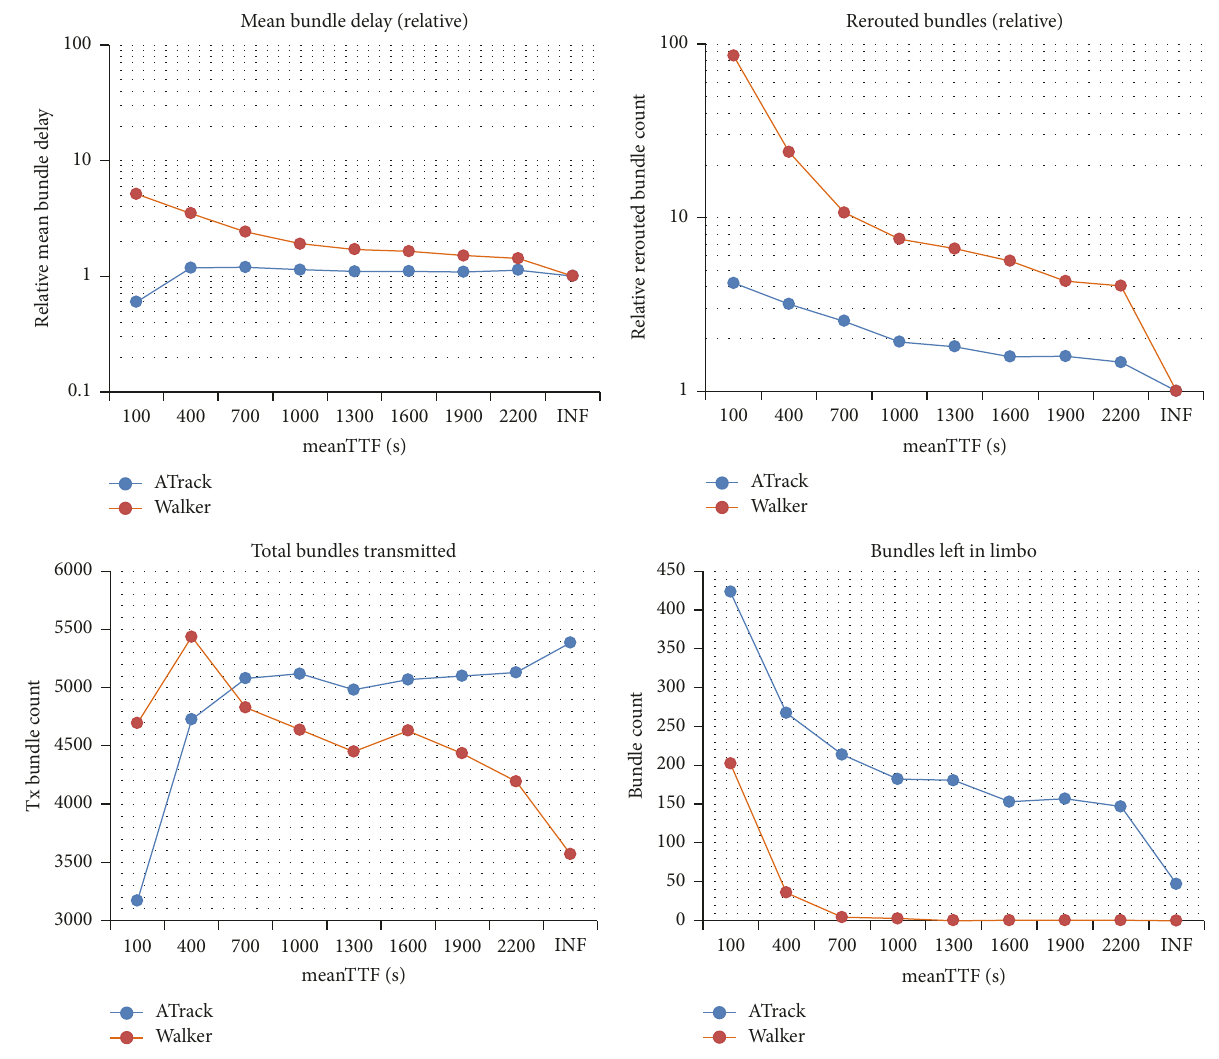
Figure 7: Simulation